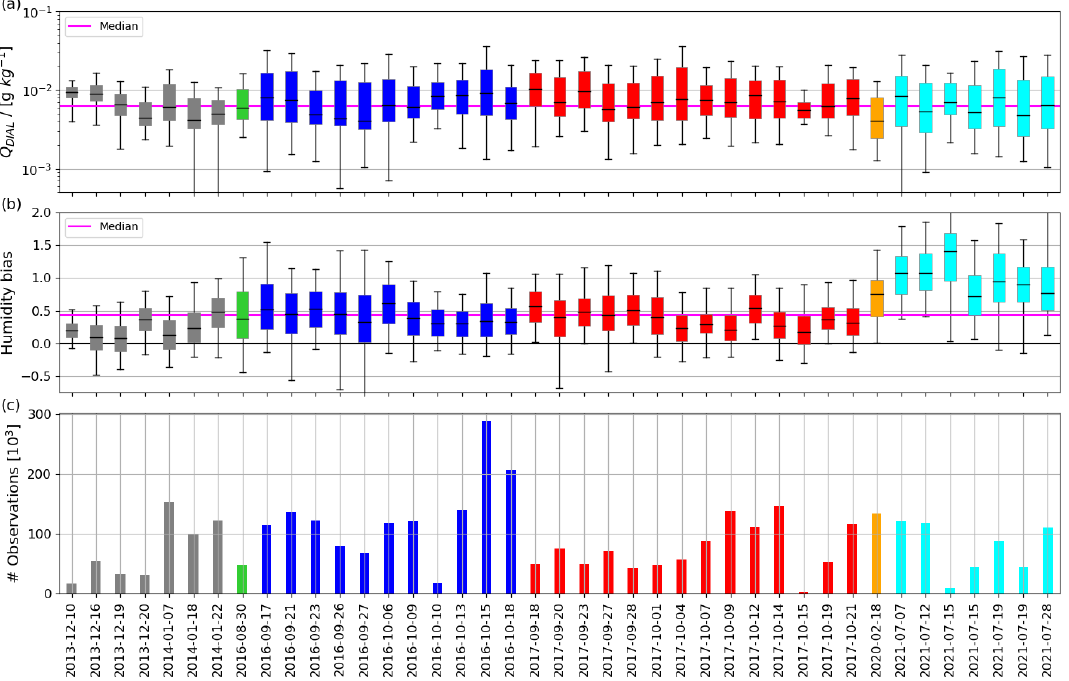
Figure 7. Distributions of (a) the observed humidity and (b) the humidity bias and (c) the number of data points for the layer 0 to 3km above the tTP. The average observed humidity and bias for all flights is given by the magenta lines in (a) and (b) . The boxes in (a) and (b) define the interquartile range located around the median (black), and the whiskers illustrate the 5th and 95th percentile. The different campaigns are colour-coded as in Fig.